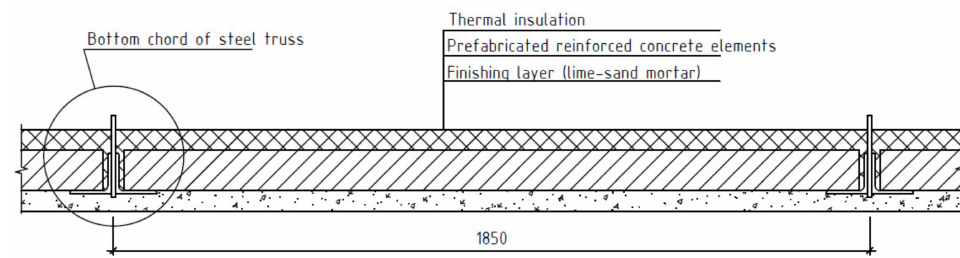
Figure 6. Construction of the existing attic ceiling (unit: